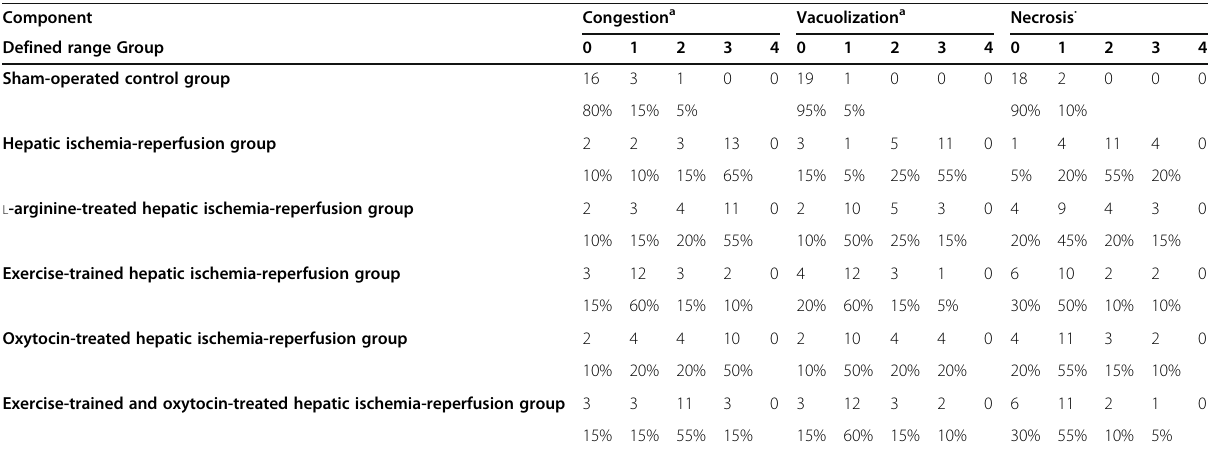
Table 3 Liver histopathological scoring system showing number and frequency distribution (%) of each component examined in two different field sections in 10 rats (20 fields/group) Component Congestion a Vacuolization